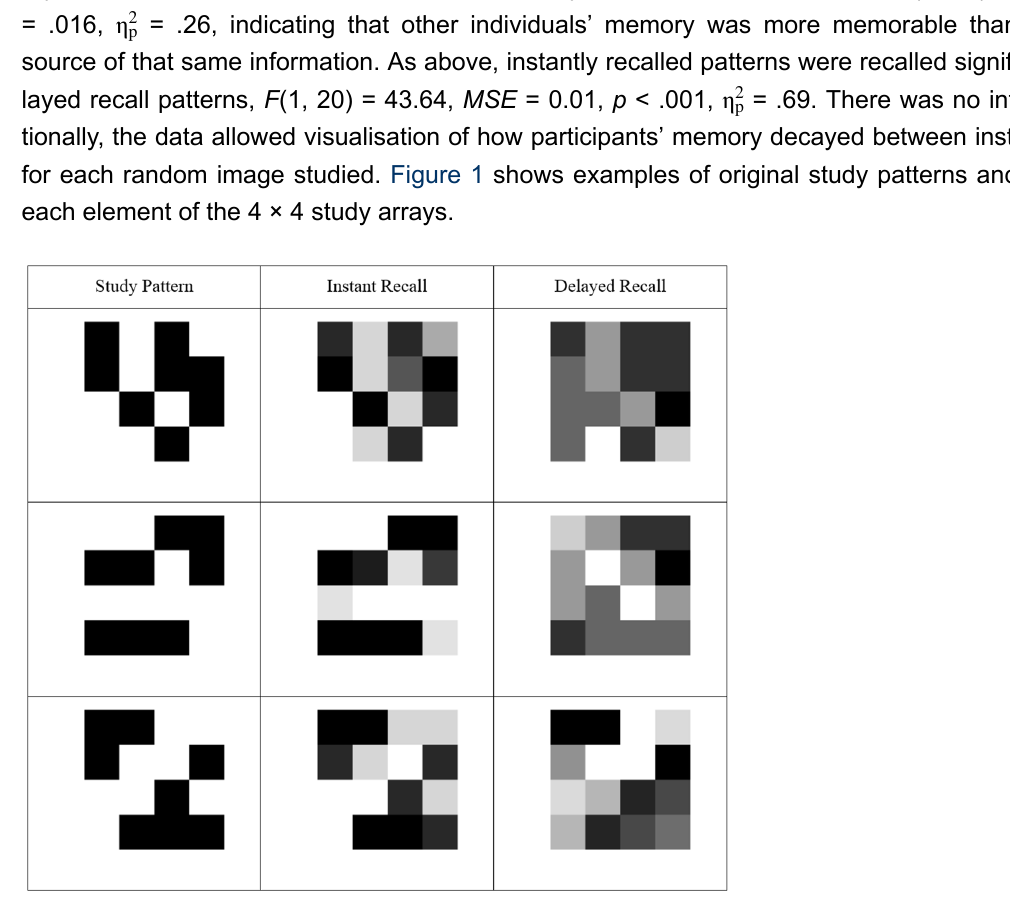
Figure 1. Mean accuracy (Experiment 1) for each element of three study patterns (left) depicted visually (percentage of participants recalling an element as black indicated from white 0% to black 100%) for instant (middle) and delayed (right) recall.